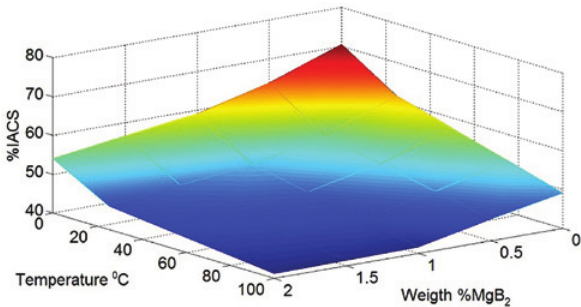
nanoparticles amount and tempera- Figure 6: Effect of the MgB 2 ture on the electrical conductivity of aluminum wires (measured as percent of IACS).